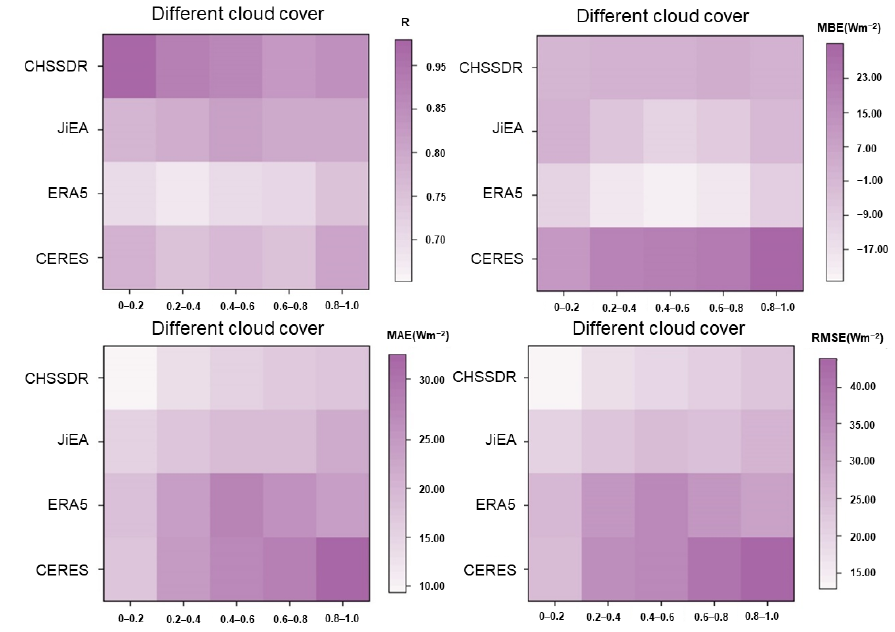
Figure 8. Validation of surface diffuse solar radiation products under different cloud fraction con- ditions.